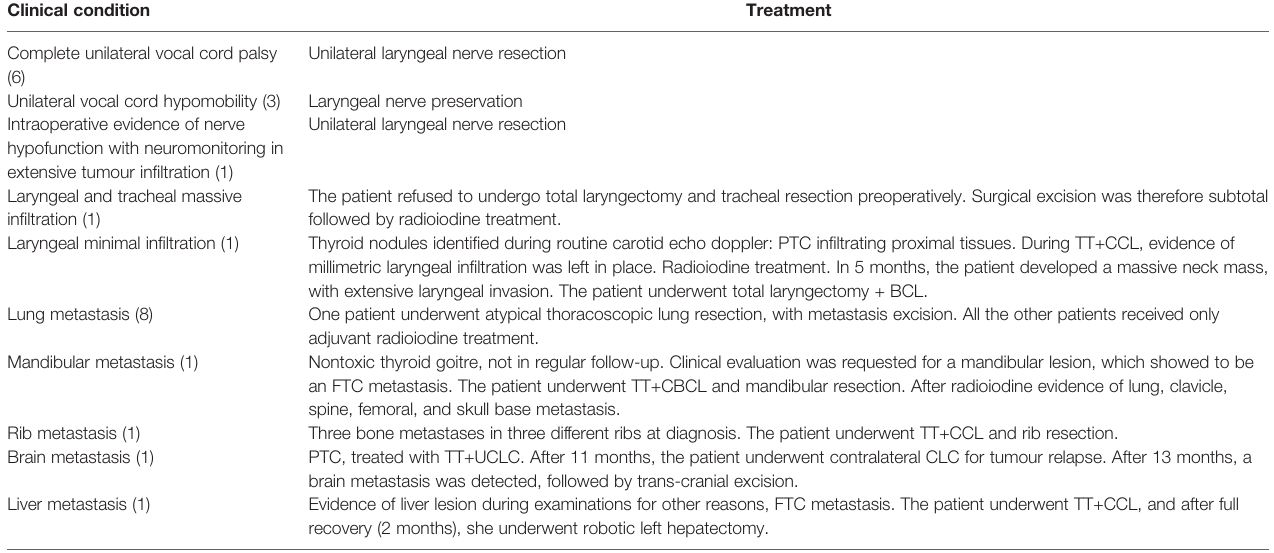
TABLE 2 | Detailed treatment received by patients in case of local advanced tumour or distance metastases. In brackets are the reported number of cases.